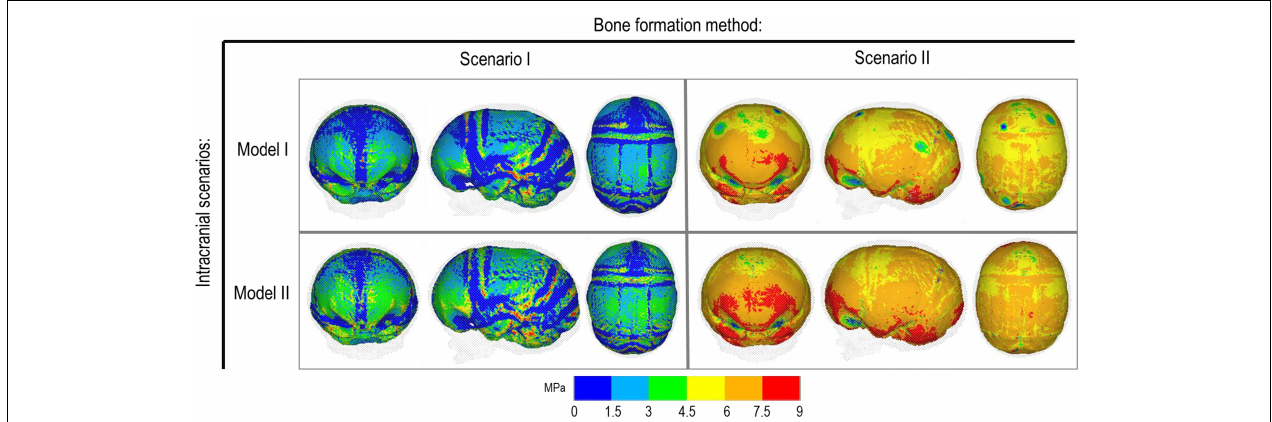
FIGURE 6 | ICV pressure map at 76 months of age. Showing the dorsal, sagittal and anterior